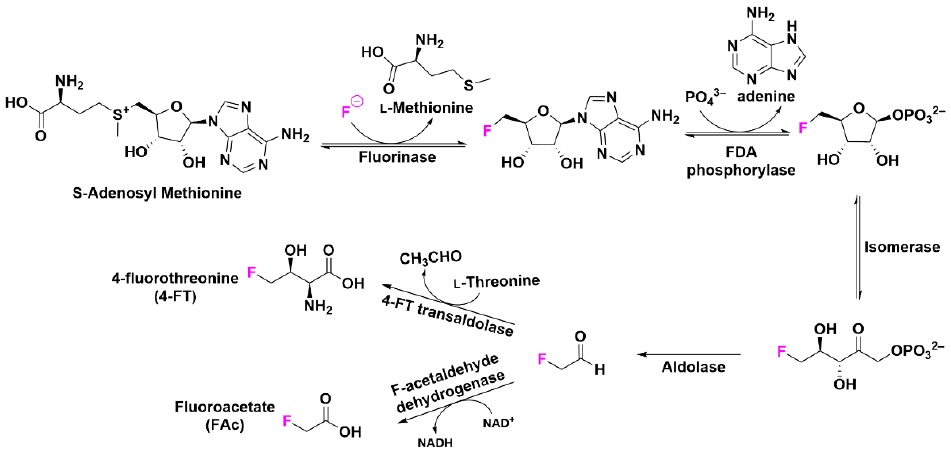
Figure 3. Proposed biosynthetic pathway of to produce FAc and 4-FT in S. cattleya. Redrawn from